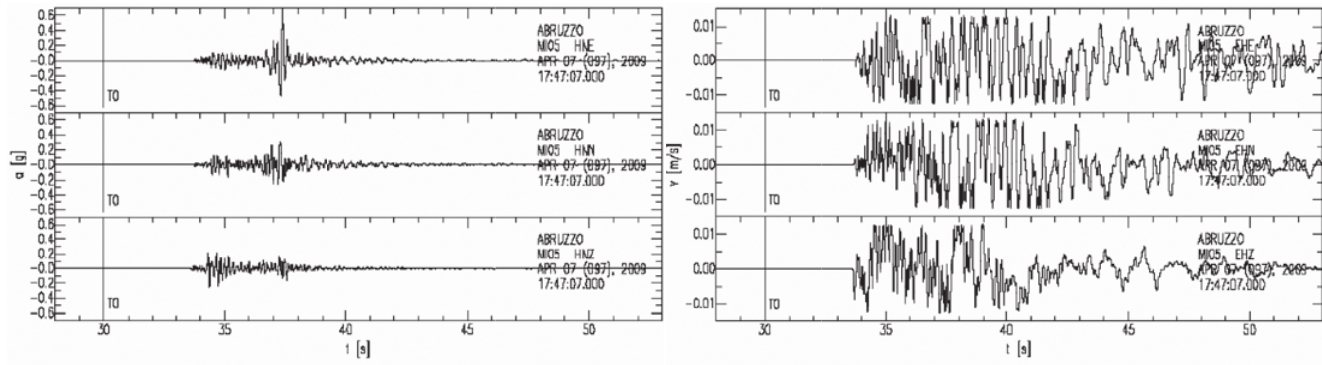
Figure 6. April 7, 2009, ML = 5.3, aftershock recorded at station MI05 by a six-component acquisition system equipped with both strong-motion (left panel; HNE, HNN and HNZ for East-West, North-South and vertical components) and weak-motion (right panel; EHE, EHN and EHZ for East-West, North- South and vertical components) sensors. It is worth noting that the strong-motion sensor (time sequences on the left) recorded the event without